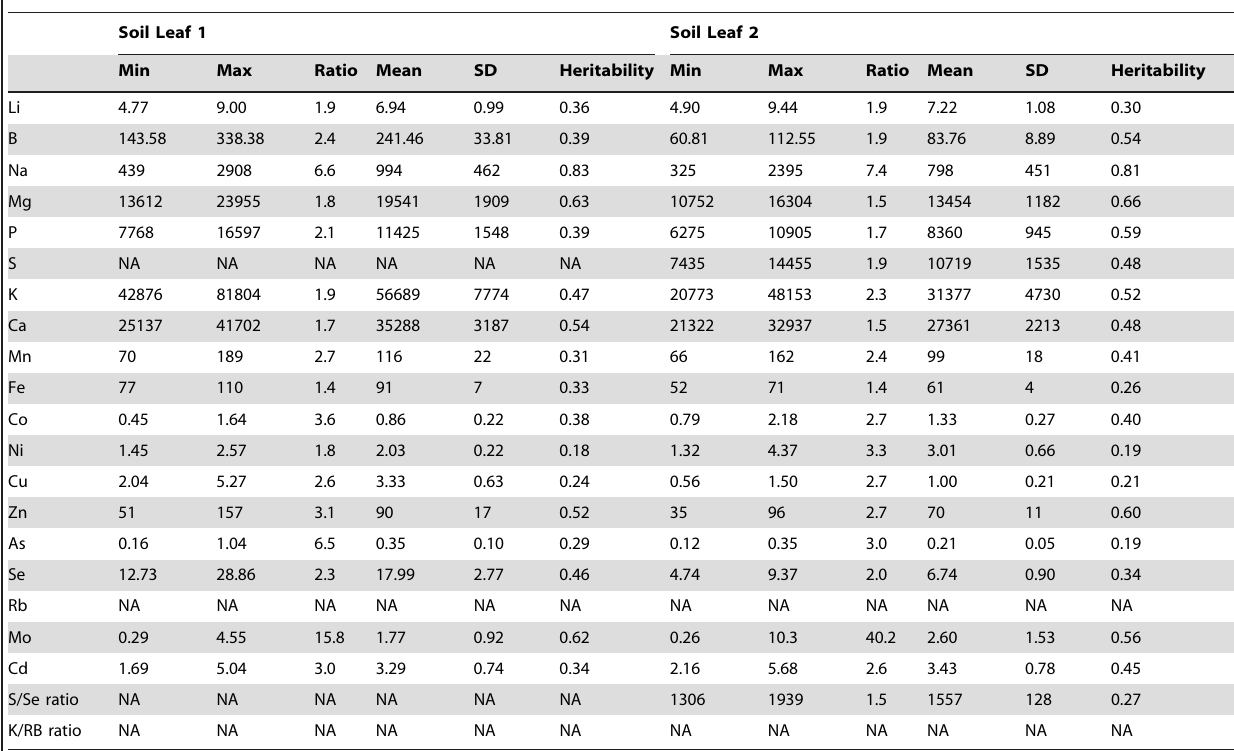
Table 2. Summary of Soil Leaf 1 and Soil Leaf 2 Experiments.